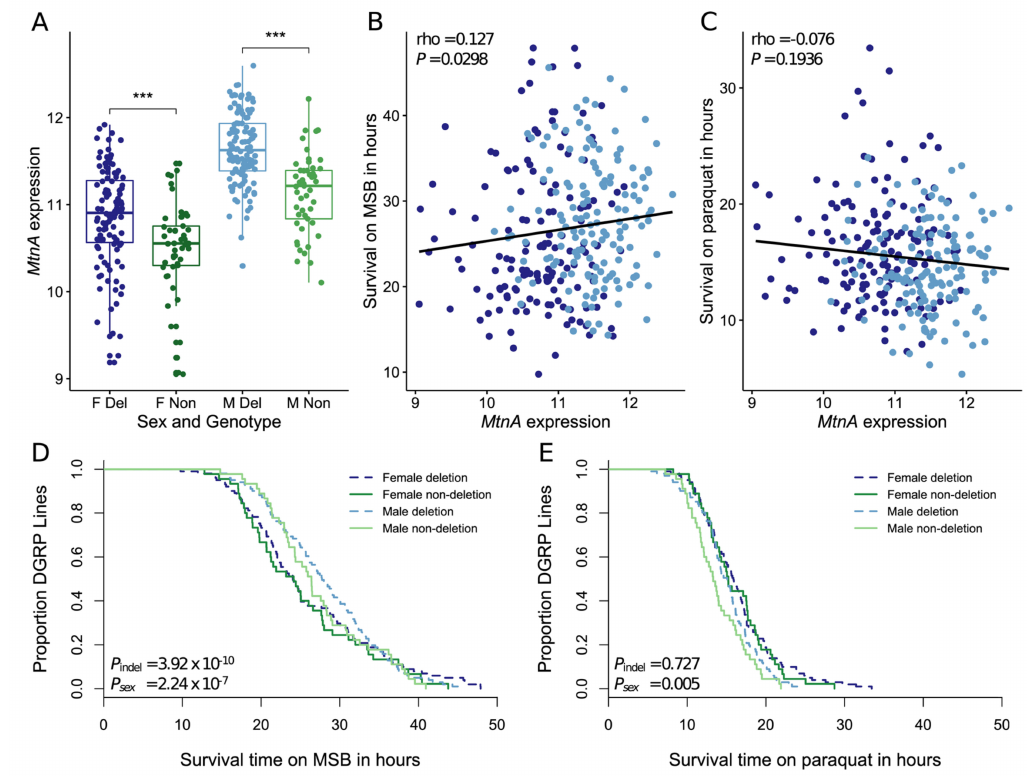
Figure 3. MtnA expression and oxidative stress tolerance in Drosophila Genetic Reference Panel (DGRP) lines. ( A ) MtnA expression in deletion (Del) and non-deletion (Non) lines in females (F) and males (M). Significance was assessed using a t-test. *** P < 0.005. Expression is reported as the log 2 relative signal intensity from Affymetrix microarrays. ( B,C ). Correlation between MtnA expression and survival on menadione sodium bisulfite (MSB) (panel B) and paraquat (panel C). Significance was assessed with Spearman’s rank correlation. Female data points are shown in dark blue and male data points in light blue. A linear regression line is shown in black. ( D,E ). Survival of DGRP lines on MSB (panel D) and paraquat (panel E). Significance was assessed using a Cox proportional hazards model with sex, MtnA indel variant, and isofemale line as factors. ( A,D,E ). Female deletion lines are shown in dark blue, male deletion lines in light blue, female non-deletion lines in dark green, and male non-deletion lines in light